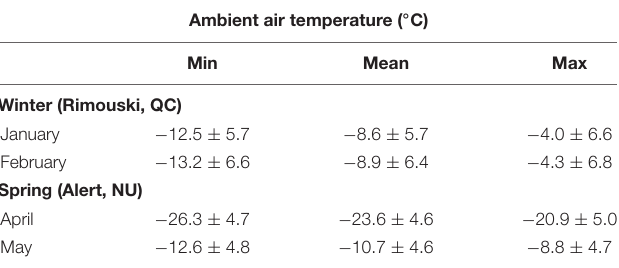
TABLE 2 | Air temperatures recorded at the peak of winter at Rimouski (QC) averaged from 2015 to 2018 and in the spring at Alert (NU) averaged from 2016 to